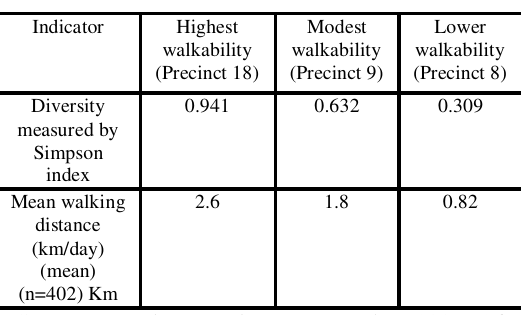
Table 3: Diversity Index Measures Values and Recorded Pedometer Distances